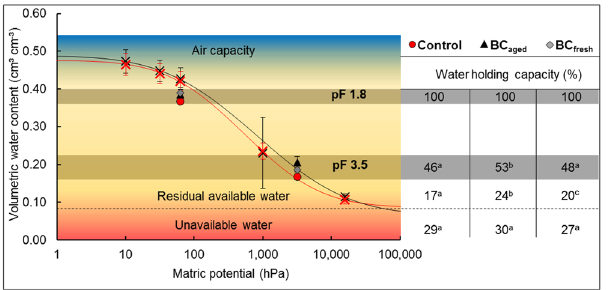
Figure 2. Volumetric water contents of the undisturbed soil samples (red (control) and the black crosses (BC aged ) (n = 12) fitted with the model of Kosugi 42 (lines)). The water holding capacities (WHC) of the pF 1.8 and 3.5 sets (n = 30) were determined after the incubation. Data within one row with different letters are significantly different (p <